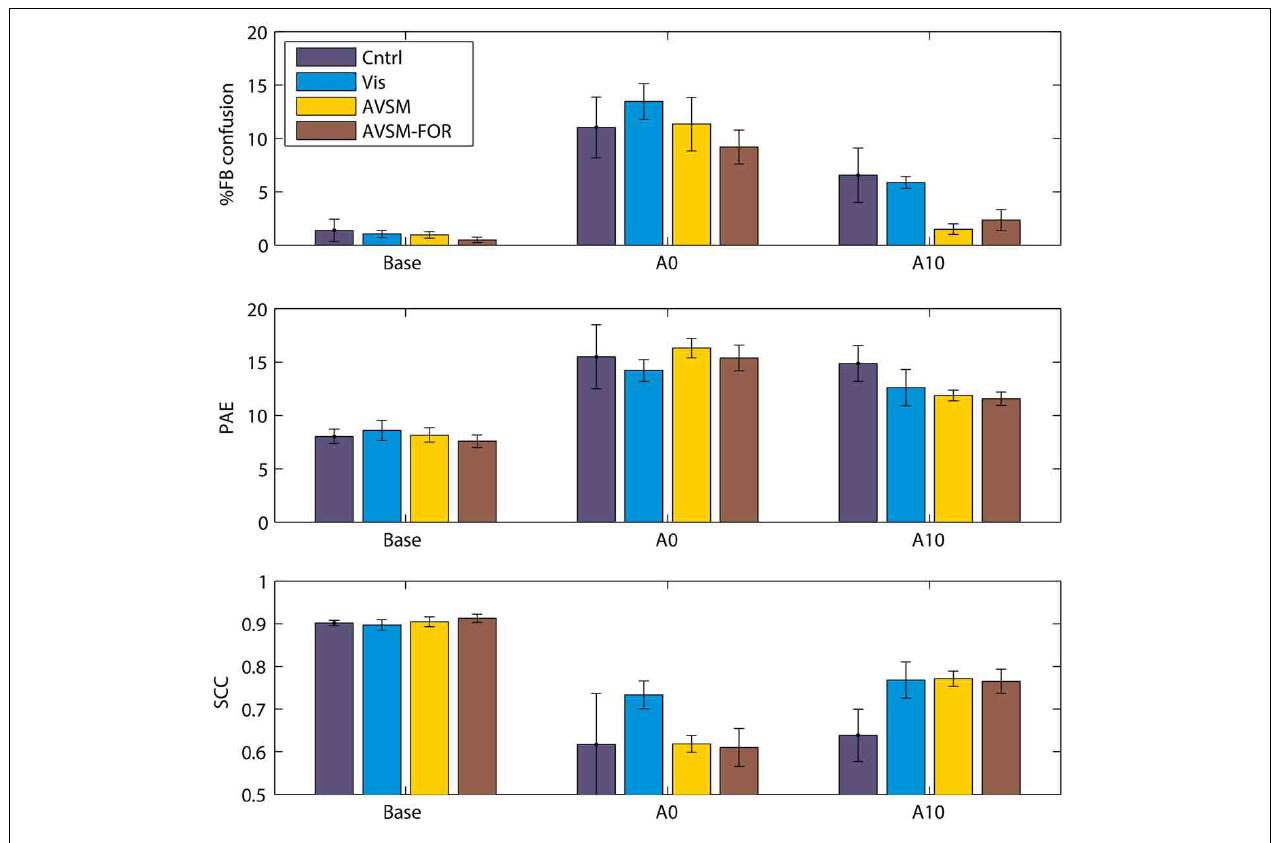
FIGURE 6 | The effects of training on accommodation to ear mold. Base: performance before accommodation with bare ears; A0: Performance on acute exposure to the mold; Acm10: